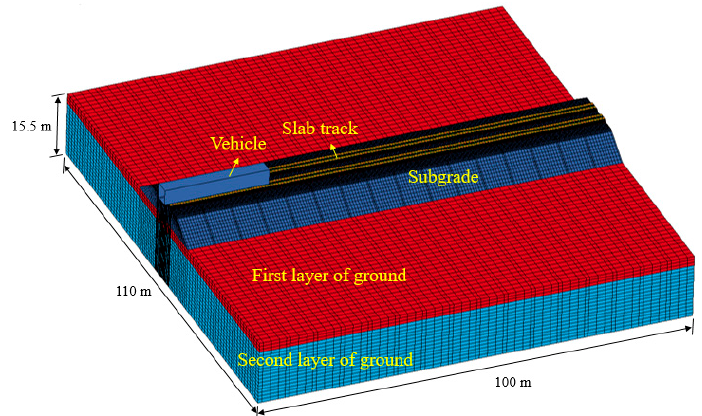
Figure 3. The 3D coupled vehicle-track-soil model.